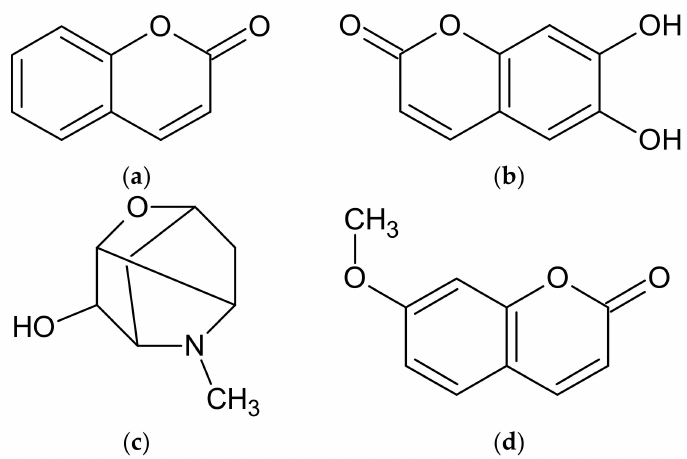
Figure 3. Chemical structure of coumarins found in Artemisia species: coumarin ( a ); esculetin ( b ); scopoline ( c ); herniarin ( d